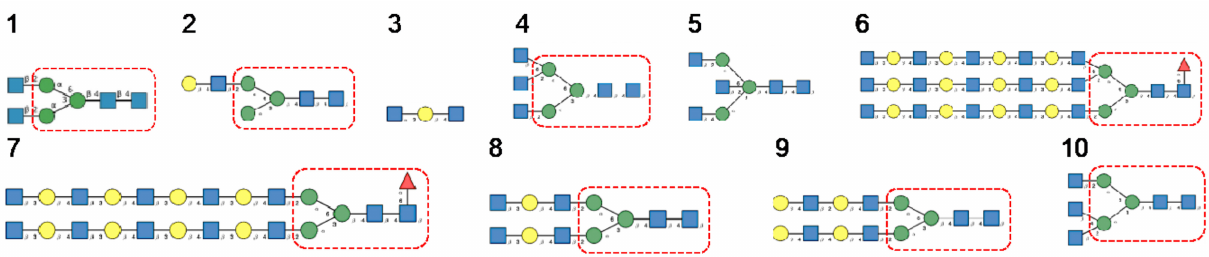
Figure 16. Glycans recognized by ABA in glycan array experiments, arranged from 1 to 10 in decreasing order of affinity.